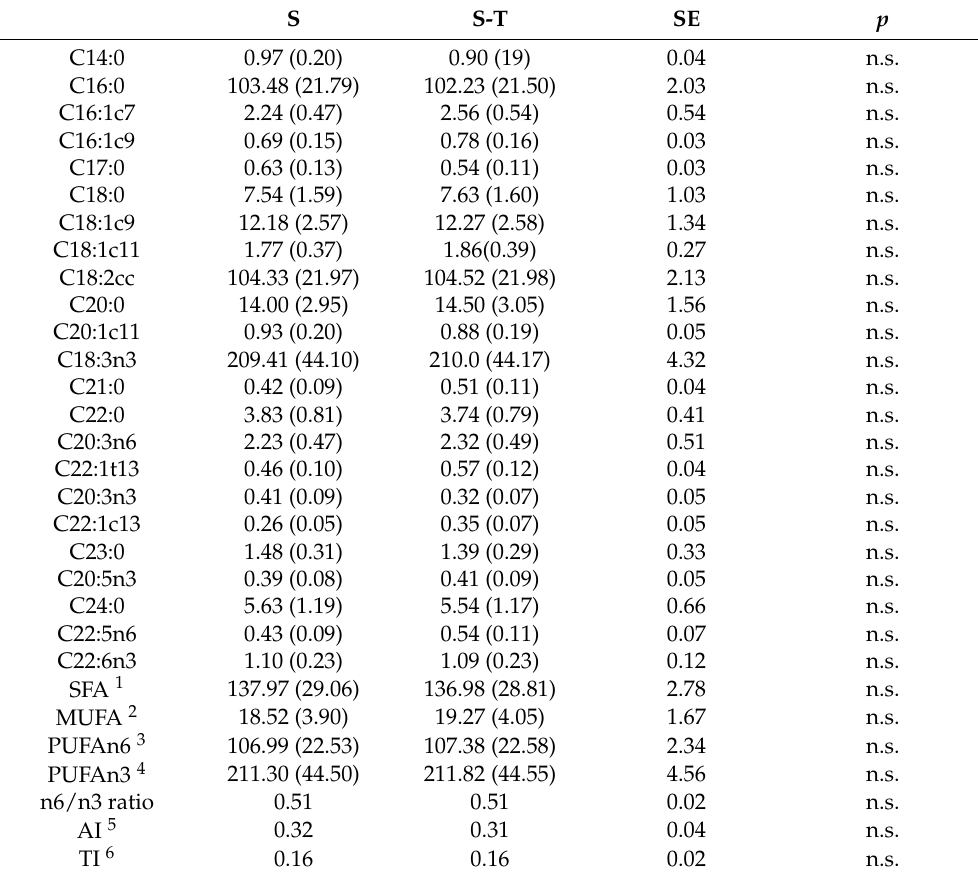
Table 3. Fatty acid profile of the edible portion of Salicornia plants cultivated in monoculture (S) or in intercropping (S-T) with tomato plants. Data are expressed as mg 100 g − 1 and represent the mean of 4 replicates. The percentage of FAME content is also reported in brackets. SE, standard error. Significance level: n.s. = not